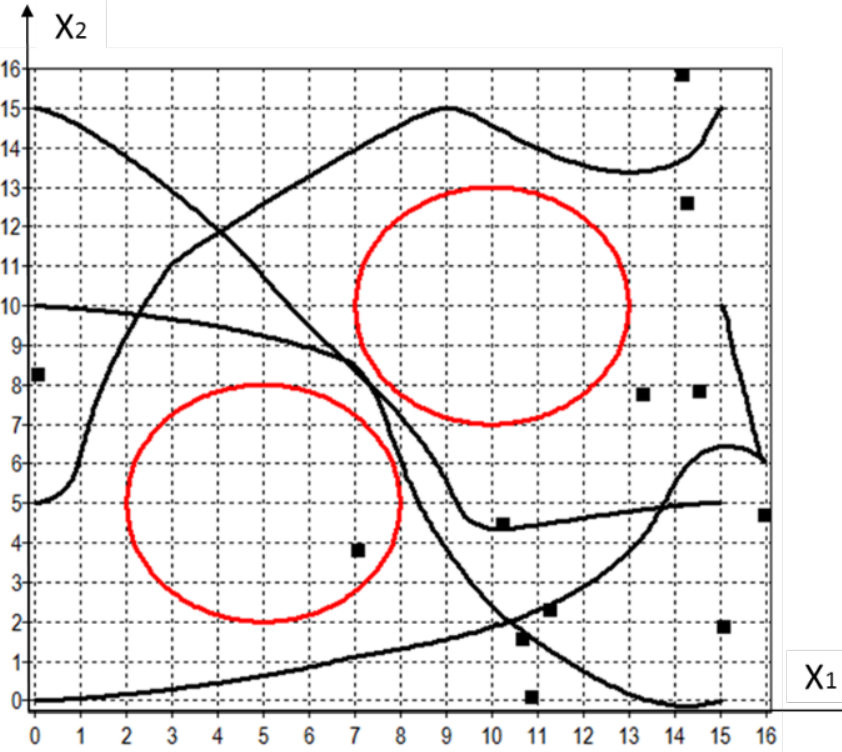
Figure 3. The solution obtained using synthesized control with GWO, 2 . 49 J = .